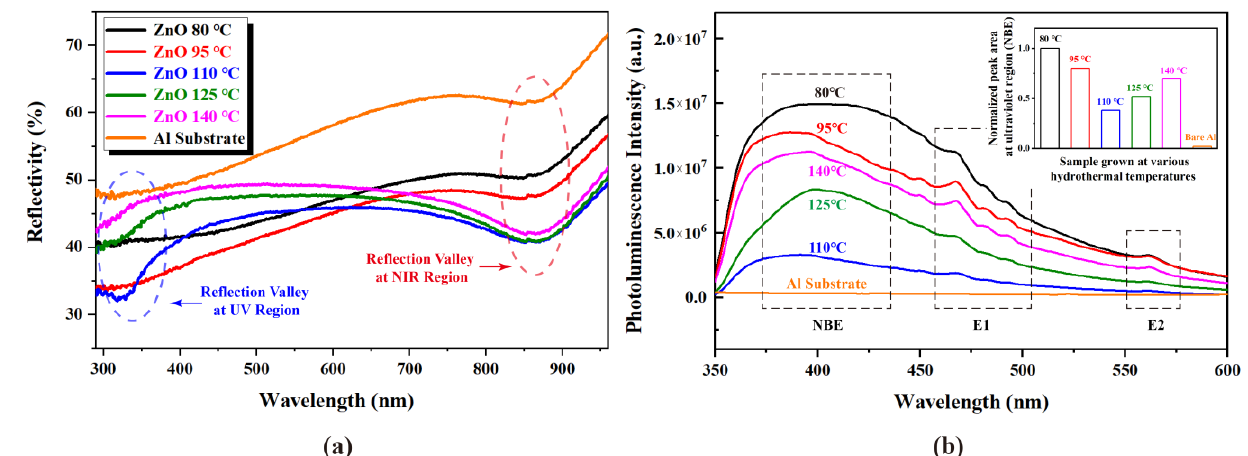
Figure 4. ( a ) UV-Vis reflection spectra ( b ) Photoluminescence spectra of bare Al substrate and fabricated nanosheet arrays grown at various hydrothermal temperatures. The inset of Figure 4b are normalized NBE’s integral areas.